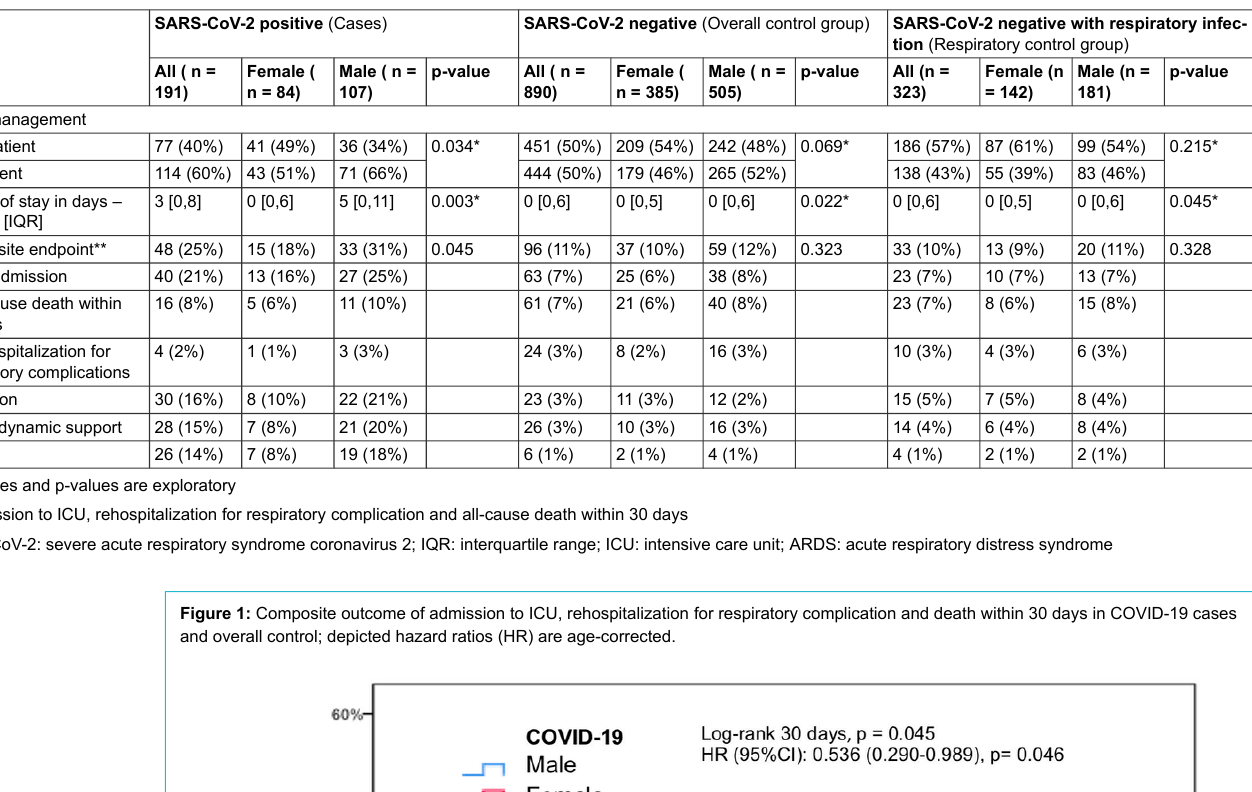
Table 2: Outcomes.